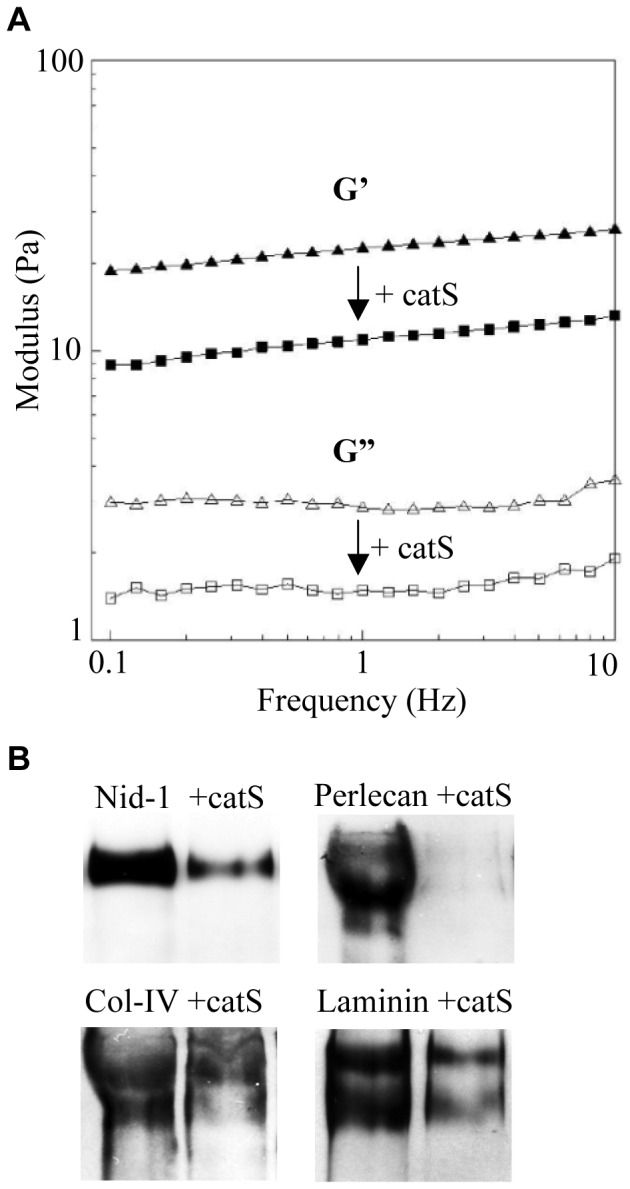
Influence of catS on the visco-elastic properties of BM matrix.(A) G’ (elasticity: black symbol) and G” (viscosity: white symbol) moduli of BM matrix (ECM gel: 8 mg/ml) without (C: control, triangles), or with catS (60 nM, squares) were determined by rheometry. A representative of three independent experiments is shown. (B) Western blot analysis of major BM constituents of ECM gel (nid-1, perlecan, laminin and collagen IV) with or without catS.